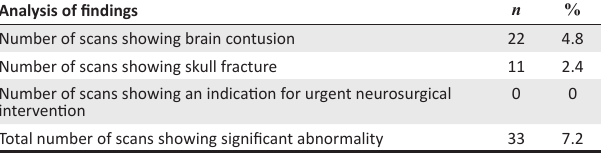
FIGURE 2: Pie chart differentiation of the abnormal computed tomography brain scans with significant and insignificant findings ( n = 460). TABLE 1: Analysis of findings in 33 (7.2 % ) computed tomography scans showing clinically significant